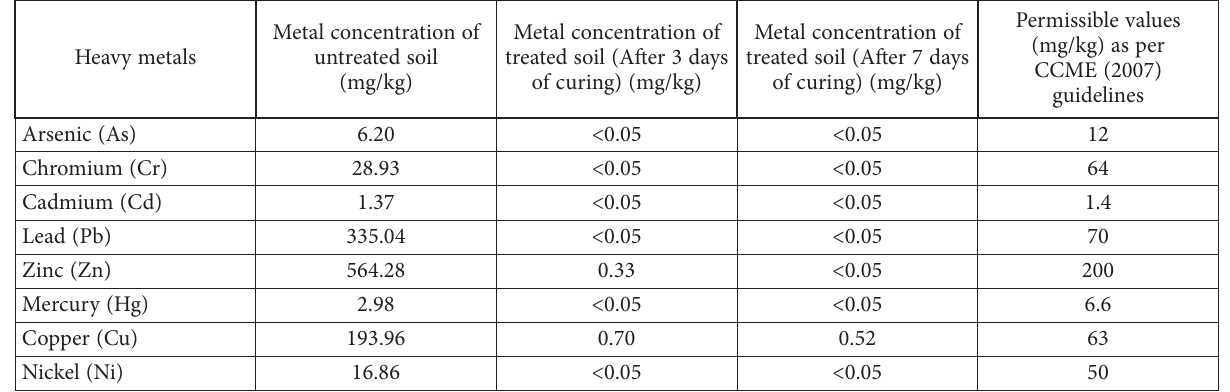
Table 2. Concentrations of heavy metals in the leachate of the untreated and treated soil